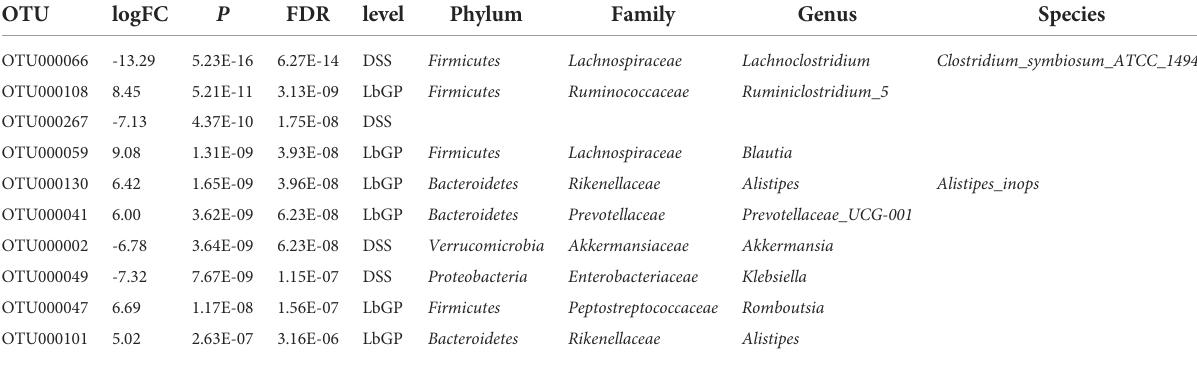
TABLE 2 Details of differential OTUs between DSS and LbGP group at W2.